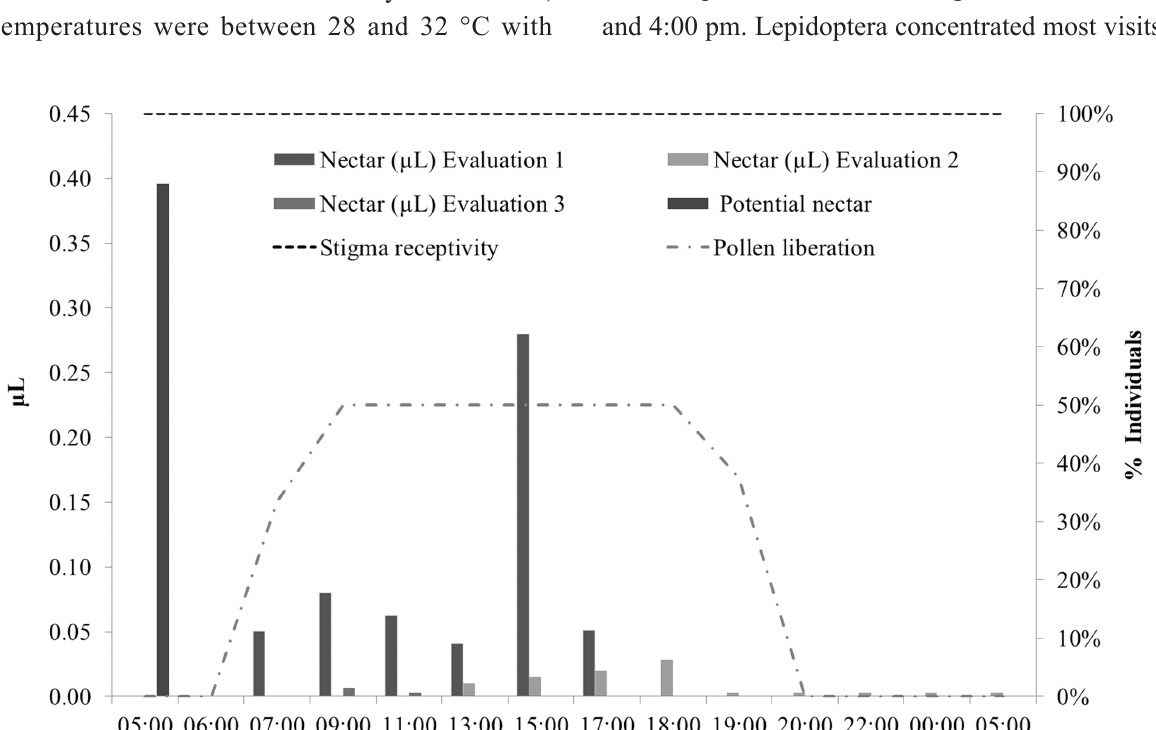
Figure 4 - Average volume of potential and instant nectar in μL per flower of Varronia curassavica Jacq. on different dates and at different hours of